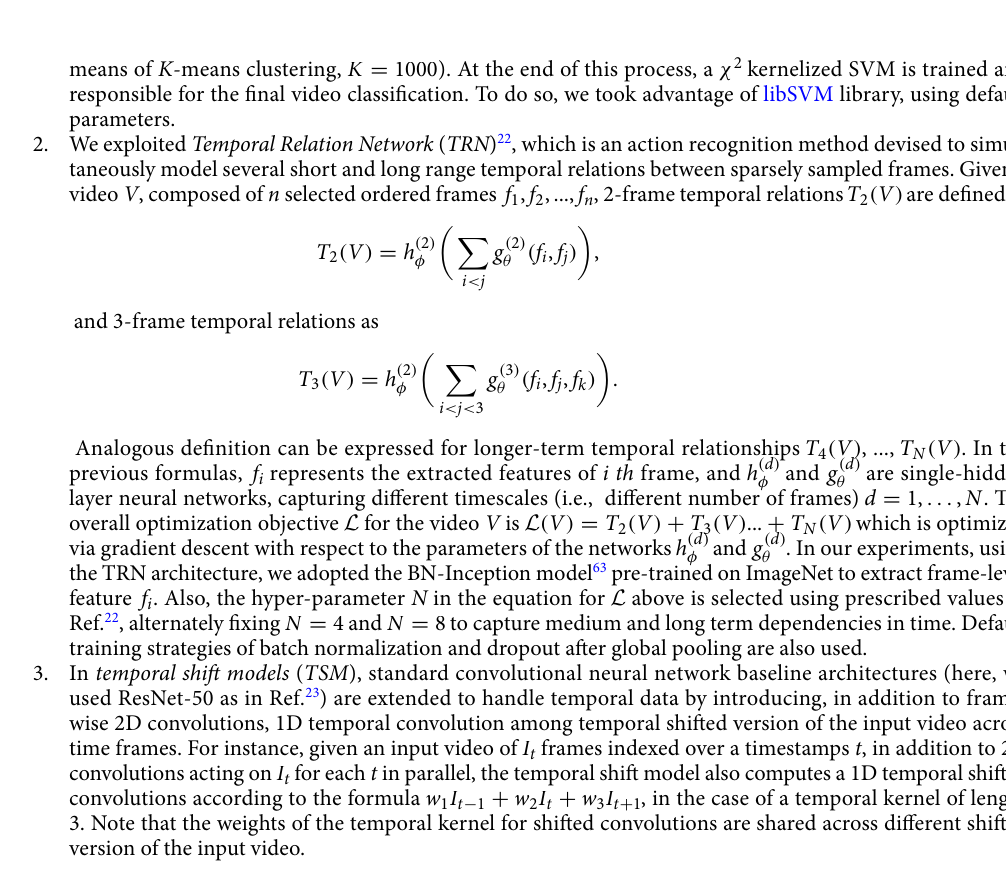
Table 4. Performance of the fusion